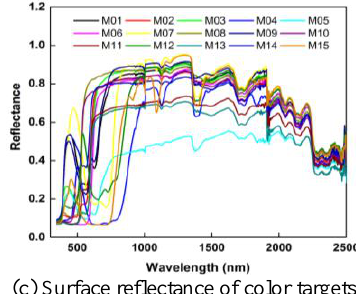
Figure 6. Portable optical artificial